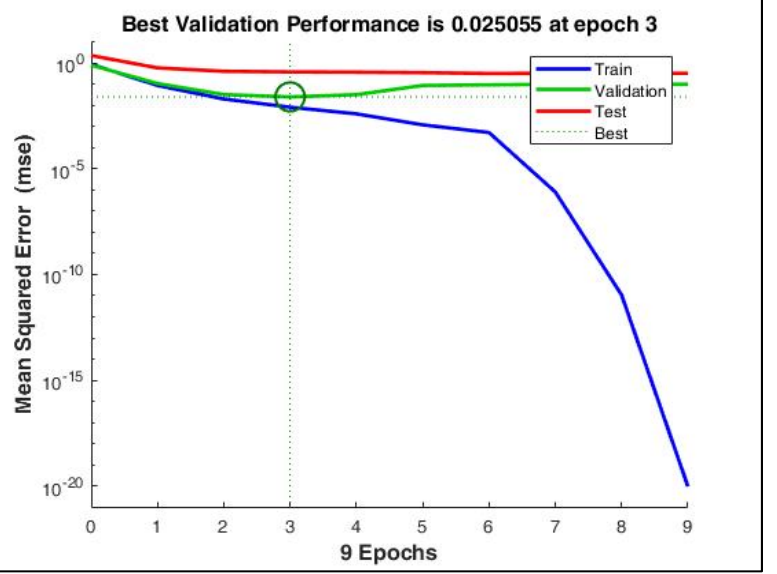
Figure 9. The mean squared error during training reduced to a very low value at the 9th epoch. However, with early stopping enabled, the best performance was obtained at the 3rd epoch when the validation MSE = 0.025.